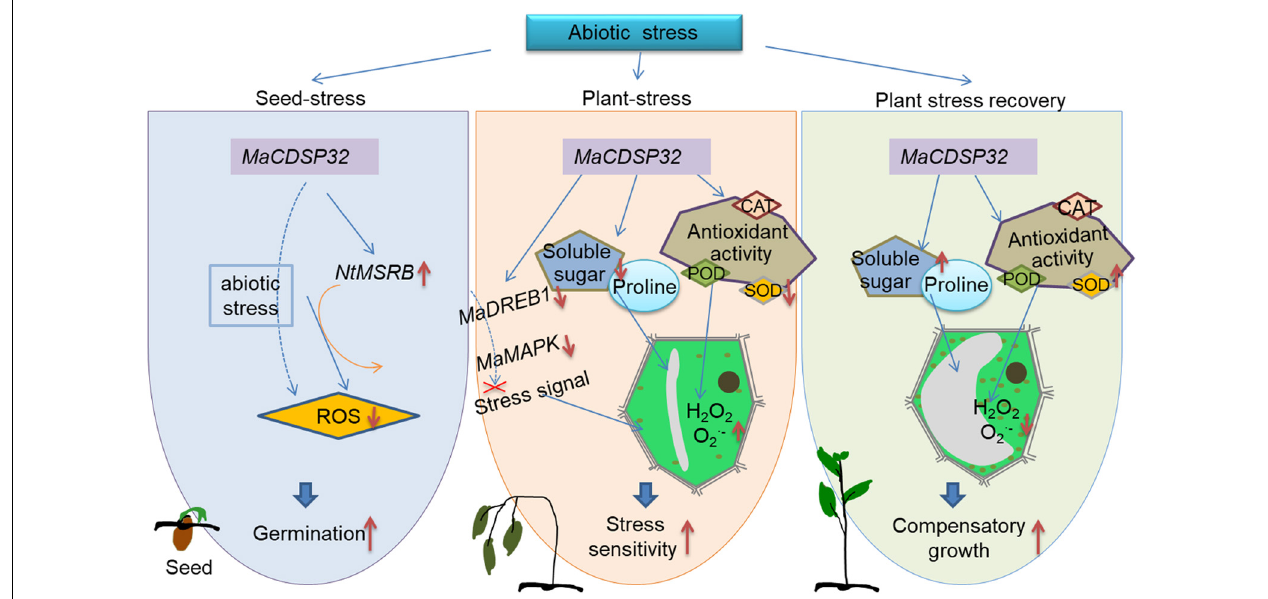
FIGURE 9 | Schematic of the contribution of MaCDSP32 to plant drought tolerance through the regulation of redox metabolism, signal transduction and osmotic pressure. The solid orange arrows represent findings from the literature; the solid blue arrows represent finding of the present study; the dashed blue arrows represent our speculations based on the findings of the present study; the red bold solid down arrows indicates downregulation; the red bold solid up arrows indicates upregulation; and the red cross mark indicates